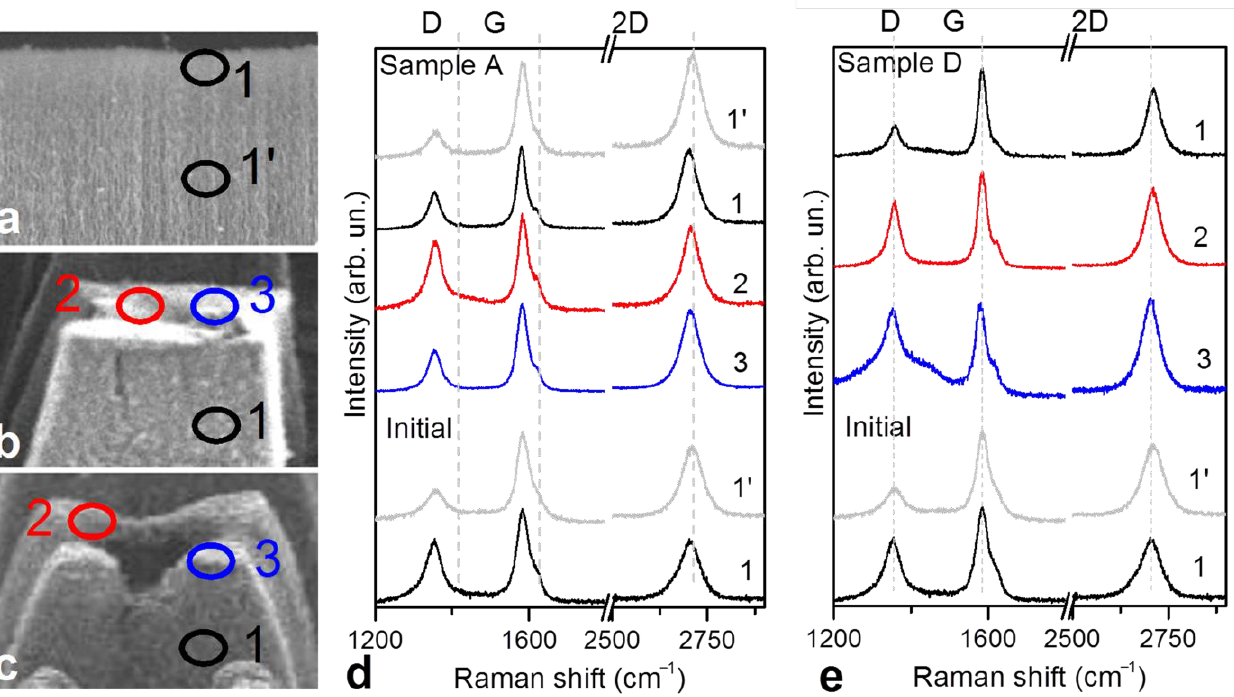
Figure 3. Points used to collect Raman spectra for initial MWCNT array ( a ), Sample A ( b ), and Sample D ( c ). Local Raman spectra of Sample A ( d ) and Sample D ( e ) compared with those of the initial array. Spectra are labeled by collection point explained in ( a , b , c ).